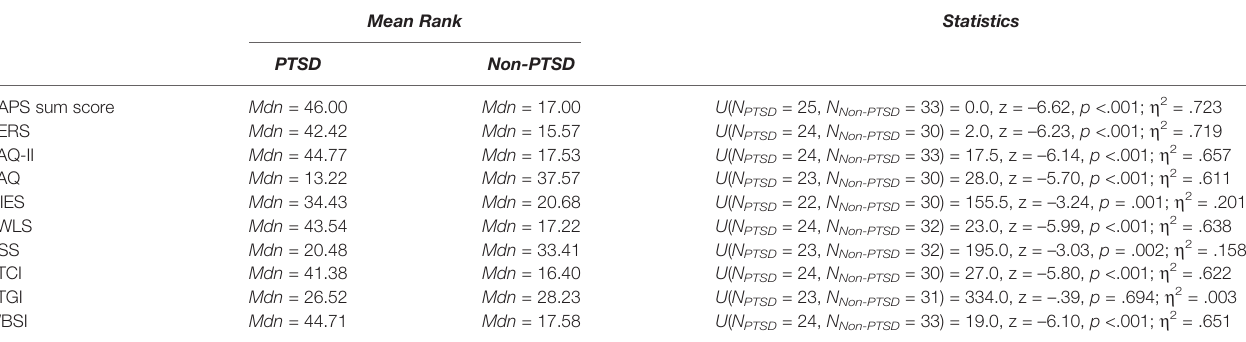
TABLE 6 | Results of Mann-Whitney-U-Tests regarding differences of mean ranks of measured questionnaires between service members with PTSD ( n = 25) and service members without PTSD ( n = 33; excluding treatment